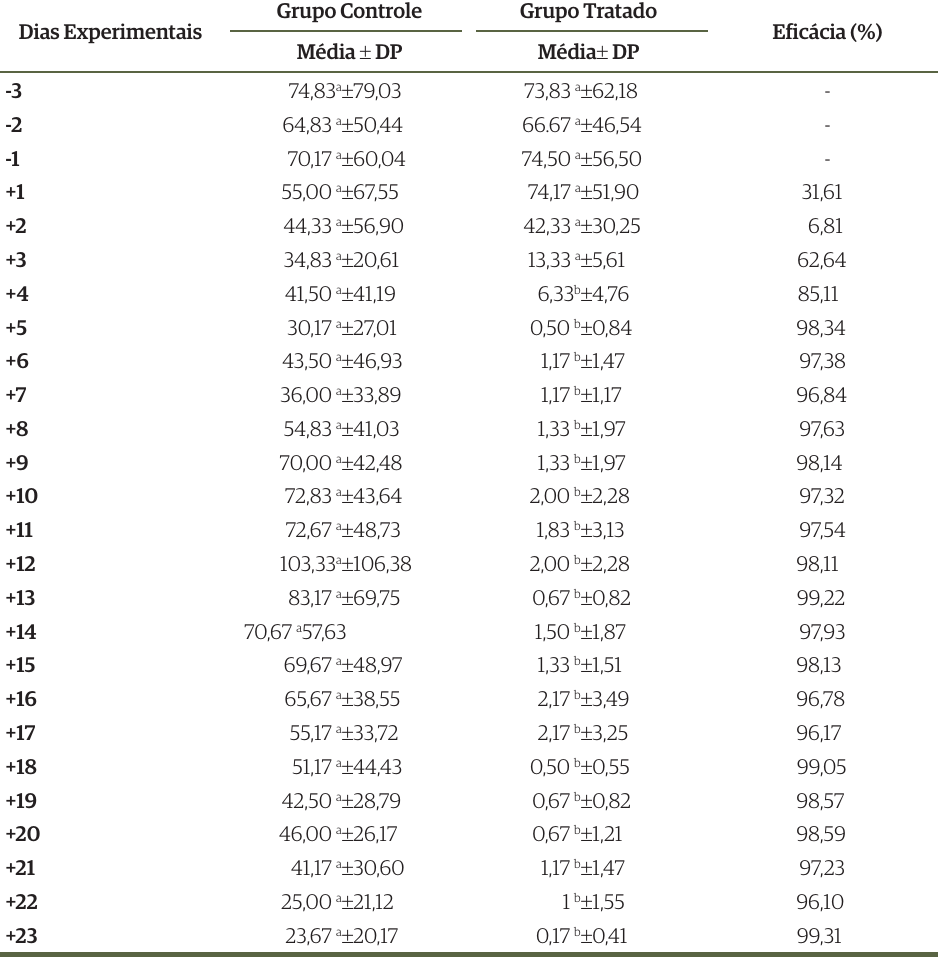
tabela 1. Média Aritmética do número de teleóginas de Rhipicephalus microplus desprendidas dos bovinos do grupo controle e tratados pela via “pour on” com a associação de abamectina 0,6% e fluazuron